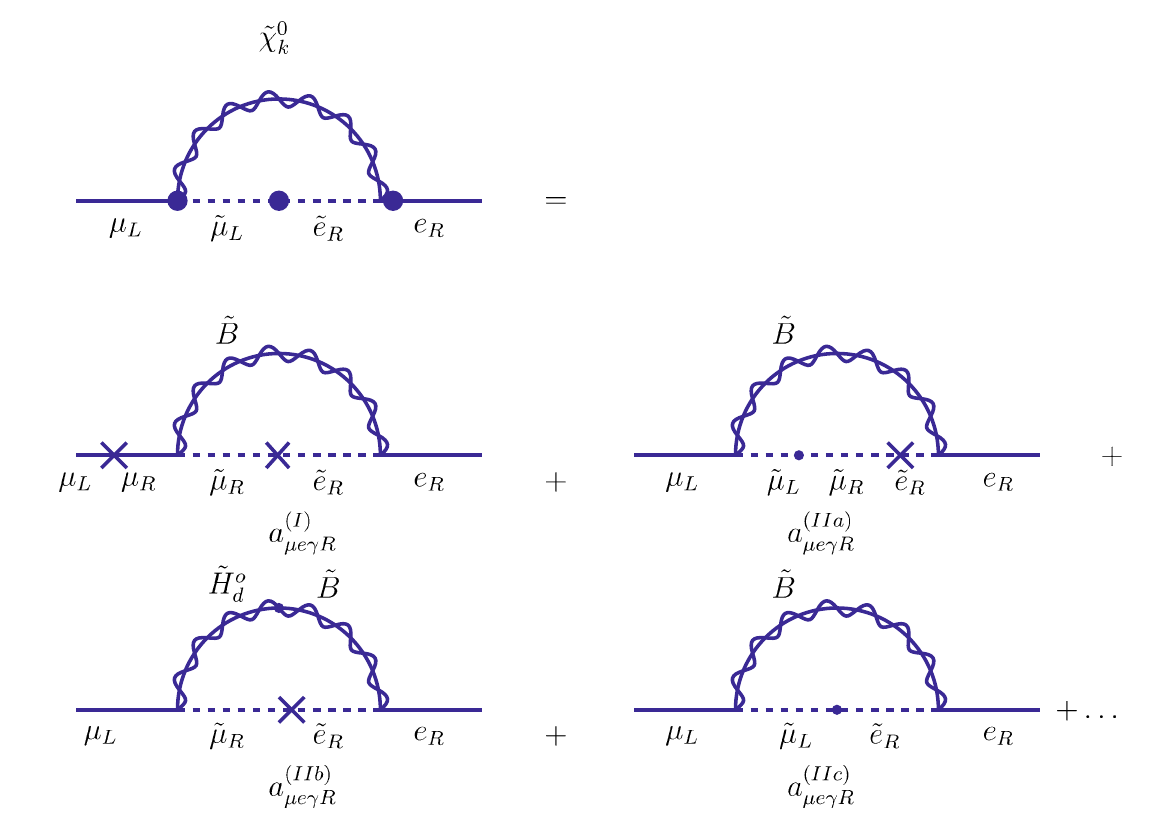
photon can couple to all charged-particle lines. The cross denotes the insertion of a flavor-mixing term that does not change chirality, and the dot an insertion that changes